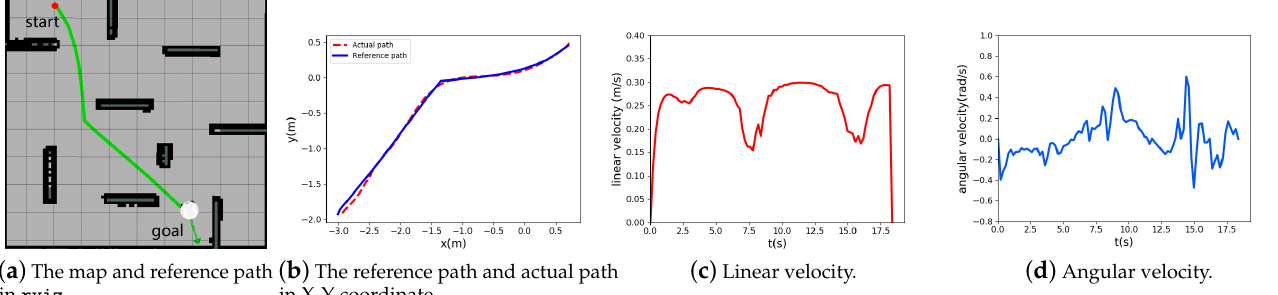
( a ) The map and reference path in rviz . Figure 13. The performance of the whole framework in a scenario with multiple